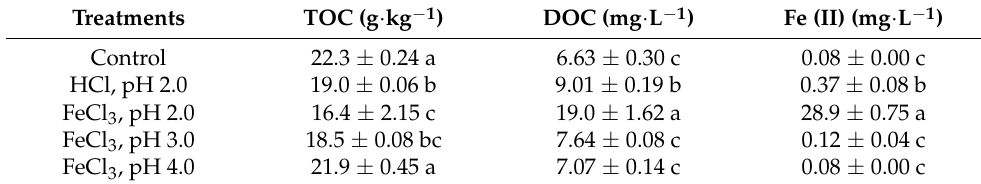
Table 1. TOC, DOC, and Fe(II) concentrations in different treatments.